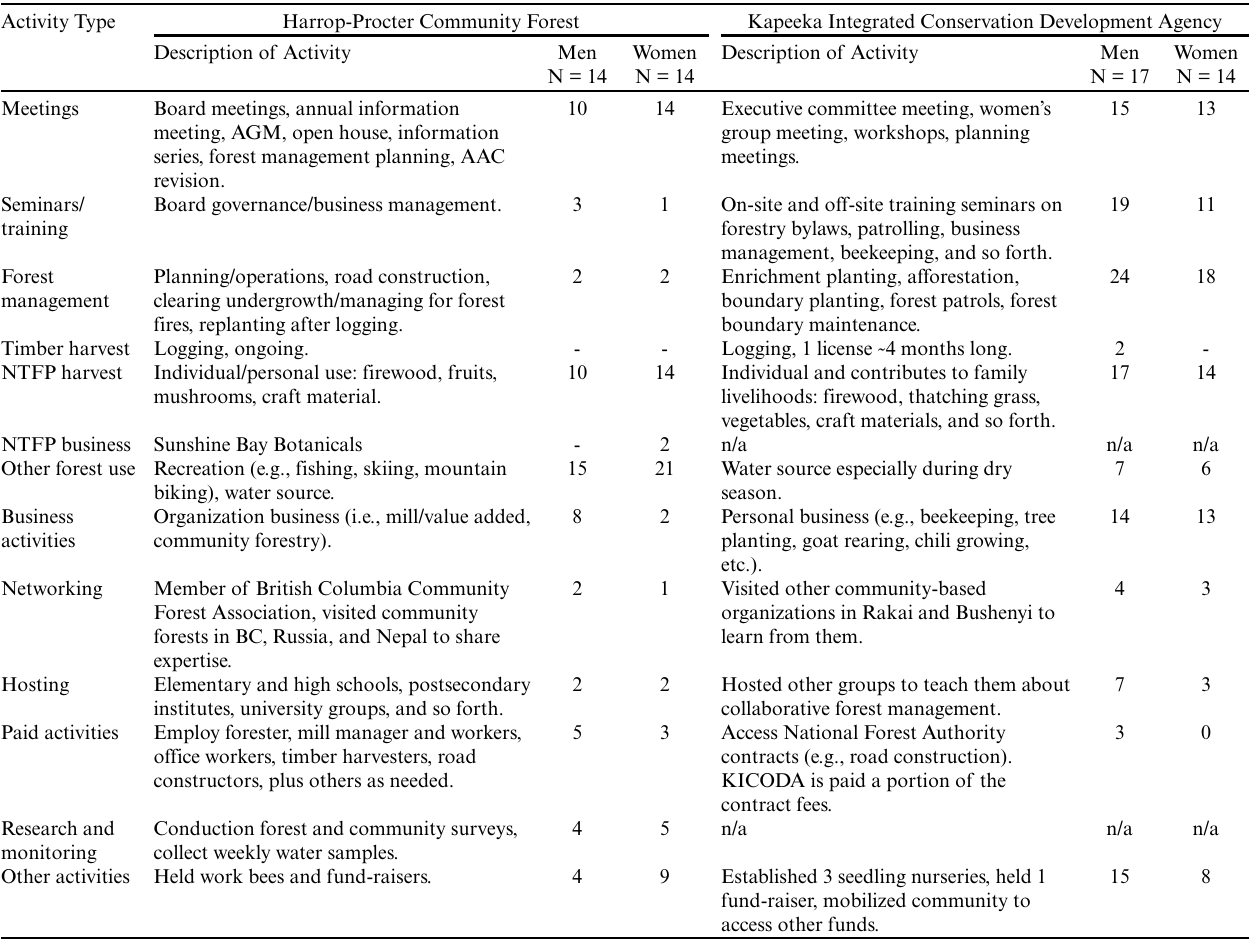
Table 2 . Participation in activities conducted by Harrop-Procter Community Forest and Kapeeka Integrated Conservation Development Agency that encouraged learning as mentioned by